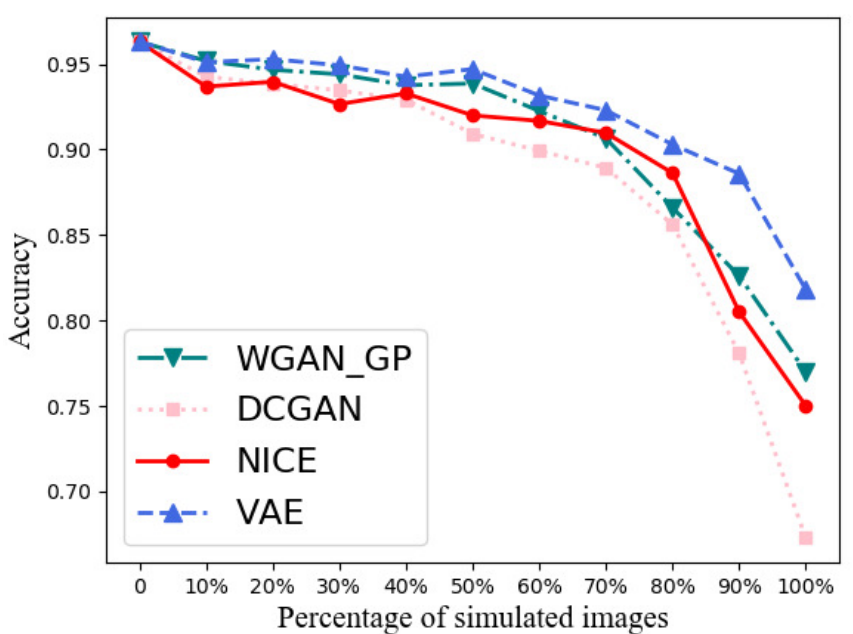
Figure 20. Hybrid Recognition Rate curves of deep generative models. The x -axis represents the ratio of substitution and the y -axis indicates the accuracy.